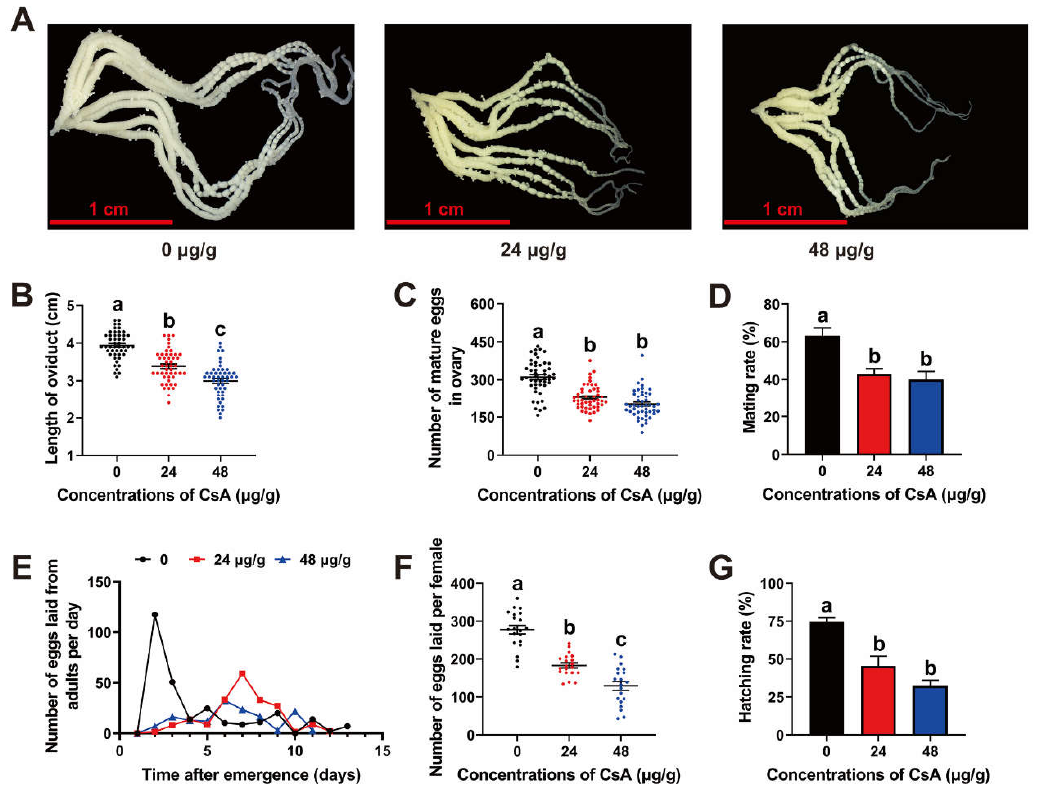
Figure 2. Post-exposure effects of CsA on reproduction of O. furnacalis . ( A ) Ovaries under the different treatments of CsA. ( B ) Ovary length under the different treatments of CsA. ( C ) Number of mature eggs in ovaries under each treatment. ( D ) Effects of CsA on mating rate. ( E ) Eggs laid by adults each day under different treatments of CsA. ( F ) Eggs laid per female under different treatments of CsA. ( G ) Hatching rate of eggs under different treatments of CsA. Data are means ± SE of more than three biological replicates. Significant differences were analyzed using ANOVA followed by Tukey’s (equal variances assumed) or Dunnett’s T3 (equal variances not assumed) HSD test on SPSS Statistics 20. Different lowercase letters indicate significant differences at level of p < 0.05.